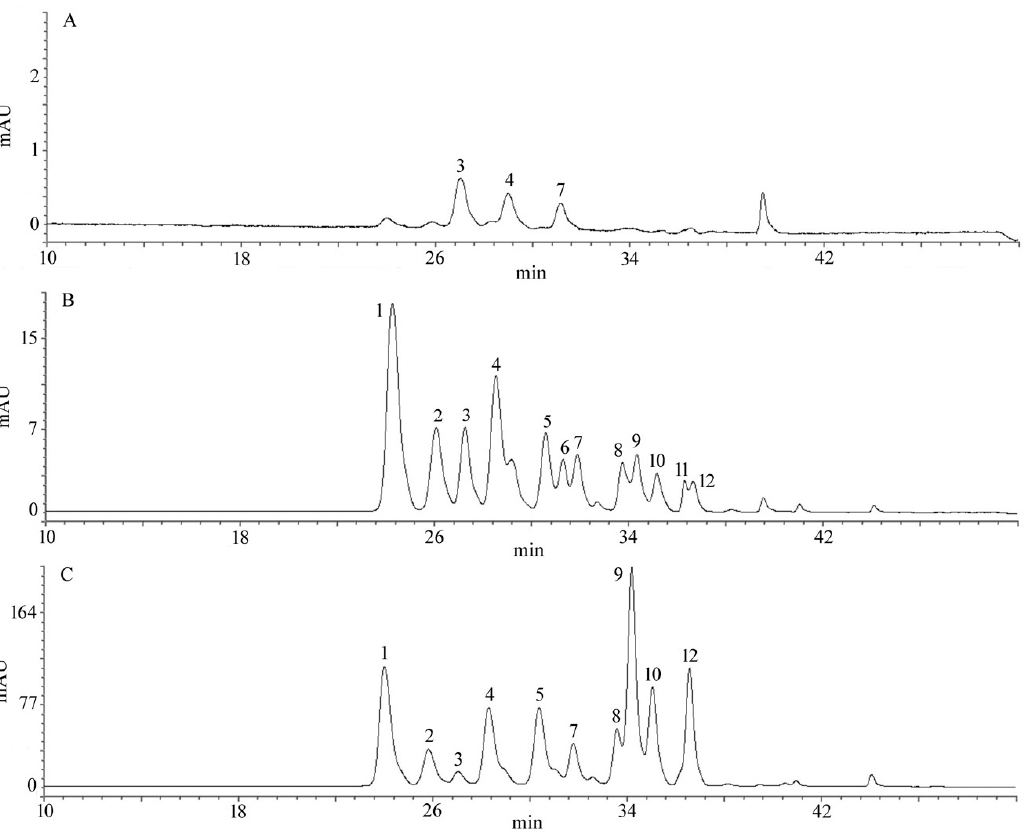
Figure 4. HPLC results of anthocyanins in different developmental stages of blueberry fruit. ( A ) green fruit; ( B ) red fruit; ( C ) blue fruit. Using HPLC at 520 nm (mean ± SD, n = 3).